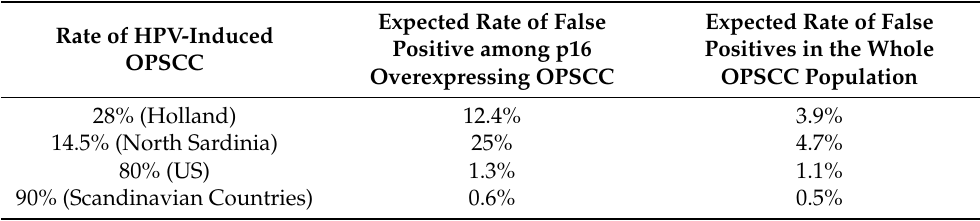
Table 2. Prediction of the rate of false positive tests (1-specificity) at p16 IHC when the reference is the combination of p16IHC + genomic DNA PCR, according to the proportion of HPV-driven OPSCCs in a given population. The calculation is made by the formula in Figure 1.